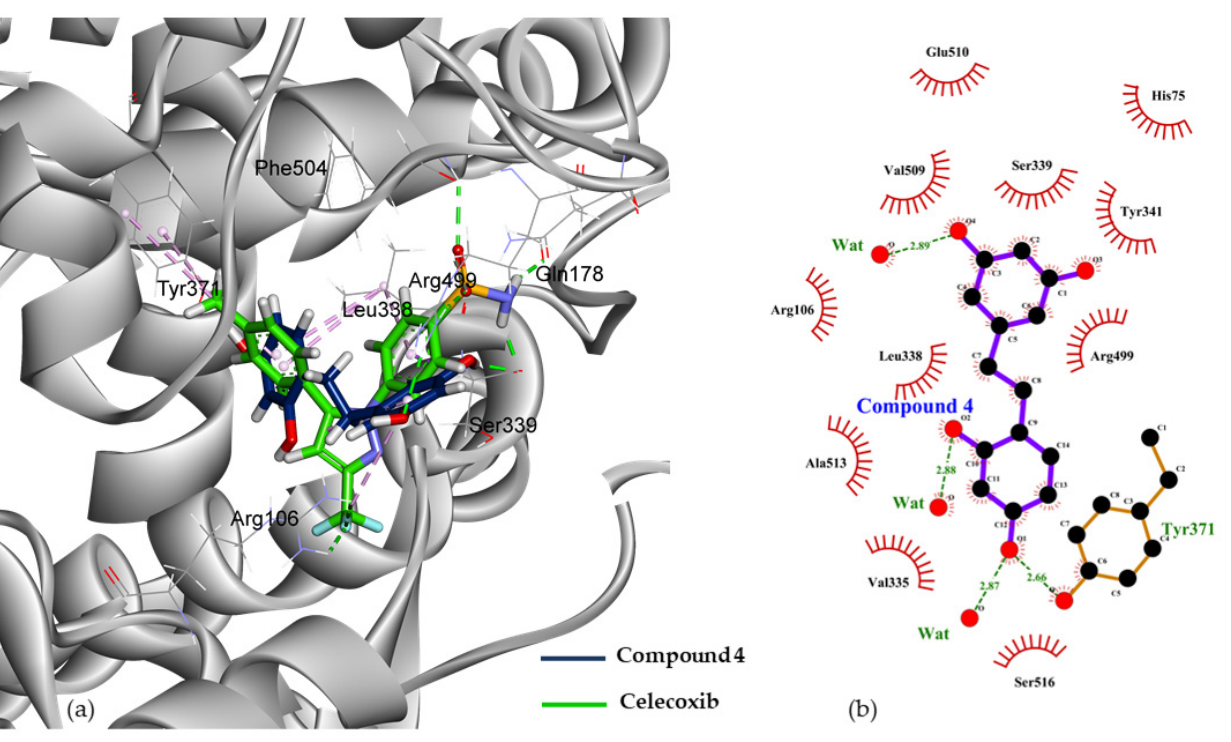
Figure 4. The lowest-QM-energy pose of ( a ) dihydrooxyresveratrol ( 4 ) (stick representation in navy blue) was overlaid on a native pose of celecoxib (stick representation in green) and in ( b ) its 2D presentation at the active site of COX-2.